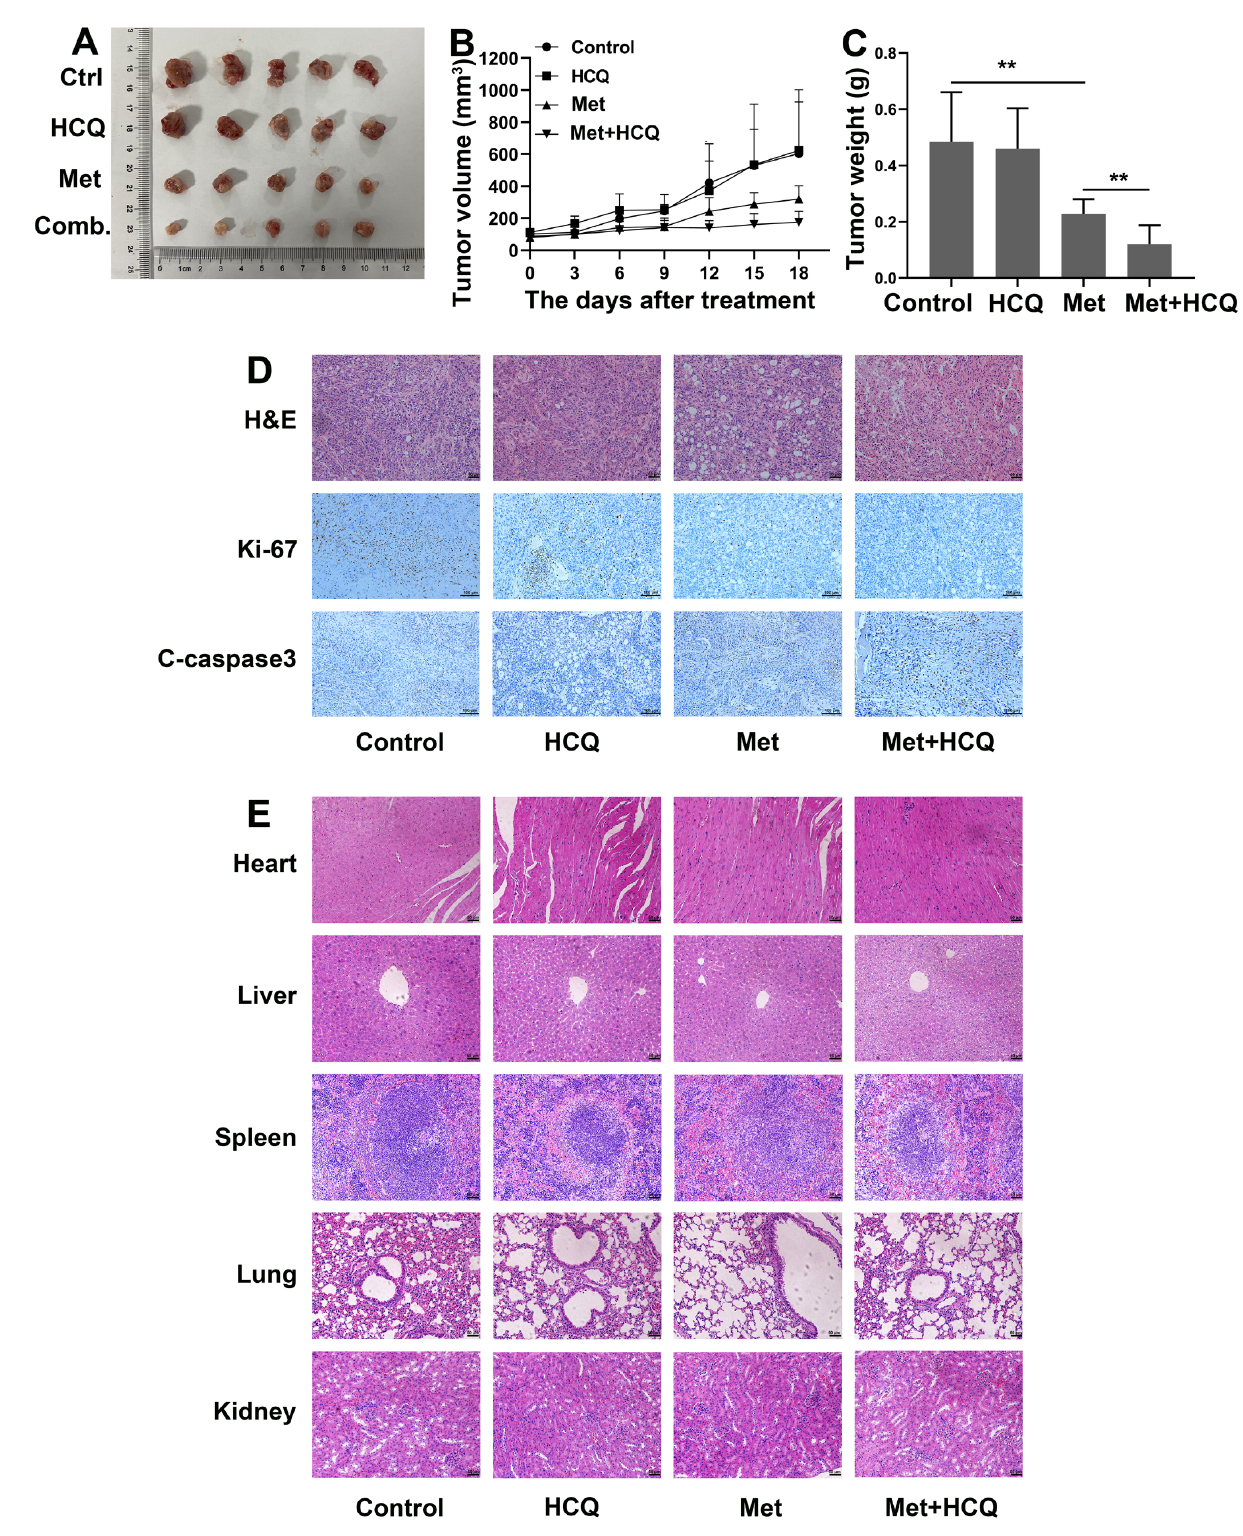
Figure 7. Metformin and HCQ synergistically suppressed OSCC growth in vivo. ( A ) CAL27 cells (1 × 10 7 cells) were injected into the subcutaneous area of female nude mice. After treatment with PBS, metformin (250 mg/kg/d), HCQ (50 mg/kg/d), and combined treatment (metformin and HCQ) for 18 days, all animals were sacrificed. ( B ) The tumor volume was measured every three days after treatment. ( C ) The tumor weight was measured after all mice were sacrificed. ( D ) The expression